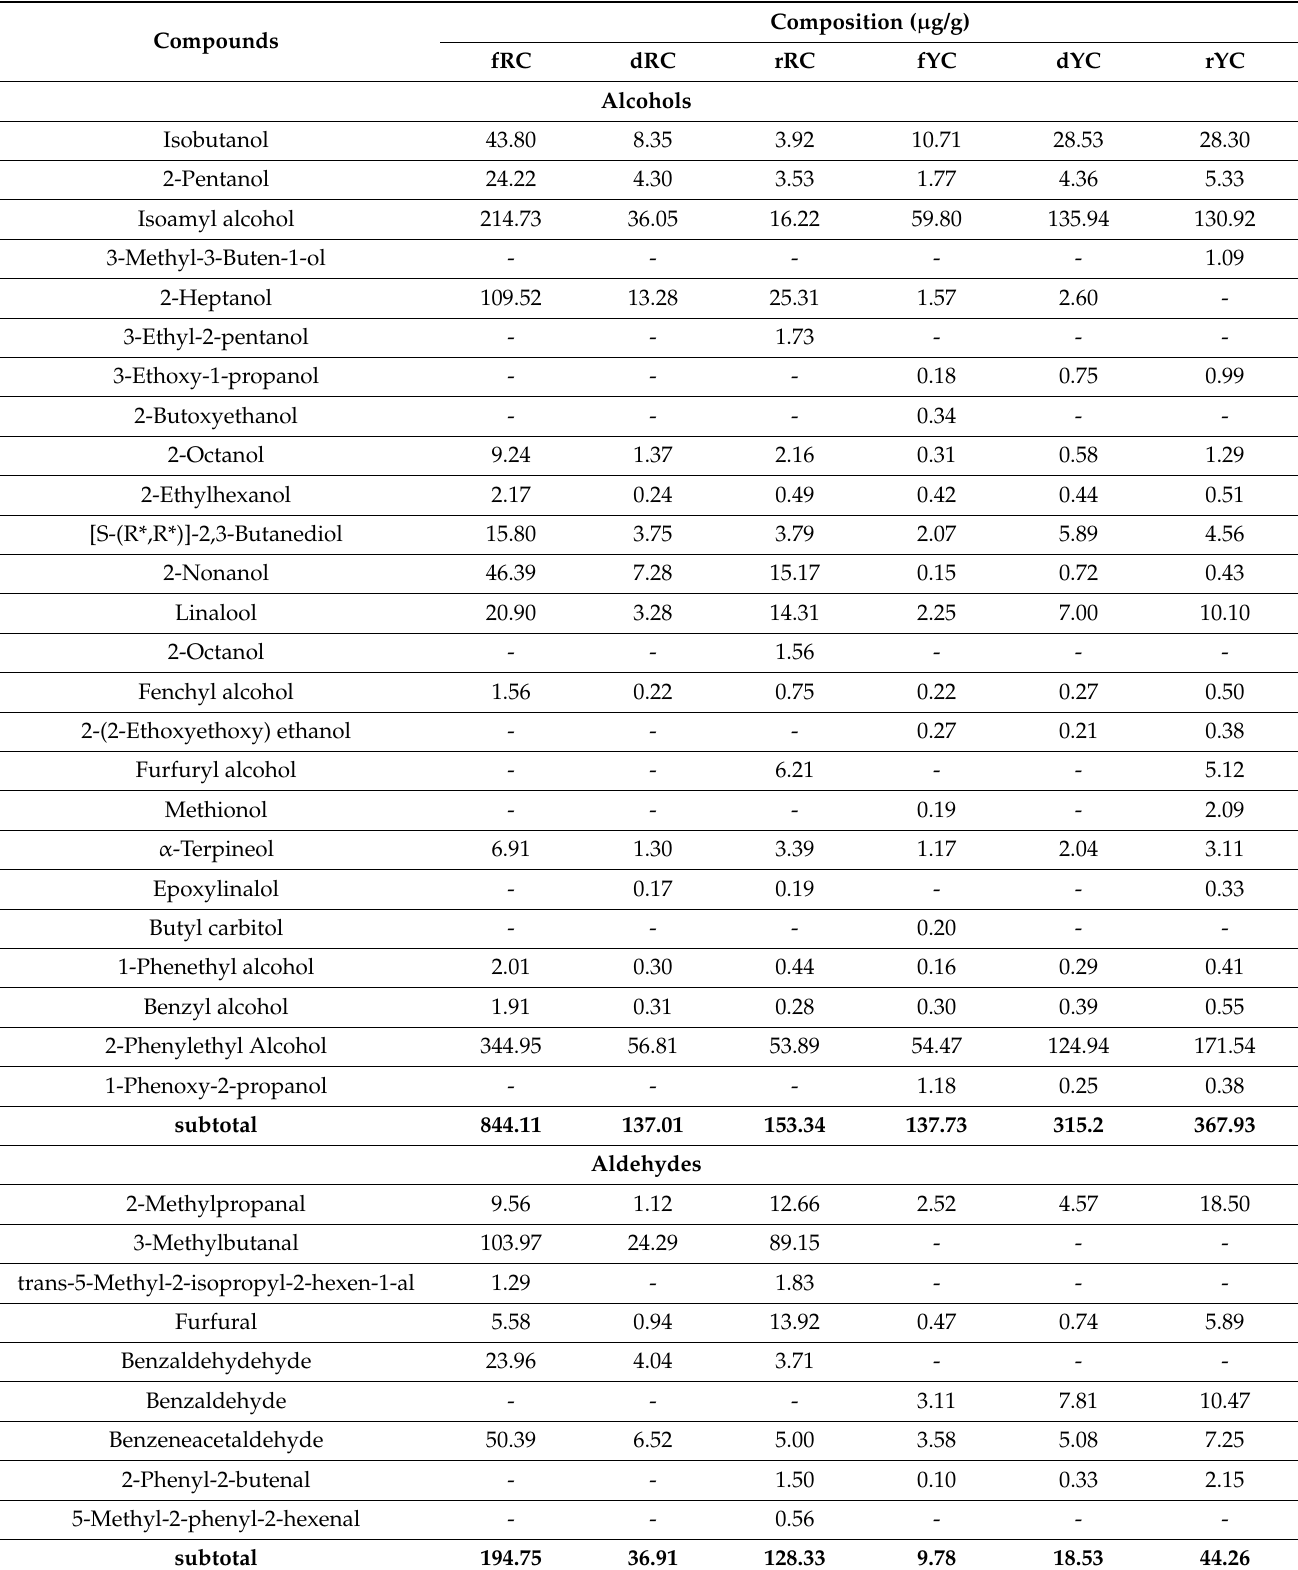
Table 10. Variation of volatile patterns in differently treated polymorphic cacao beans